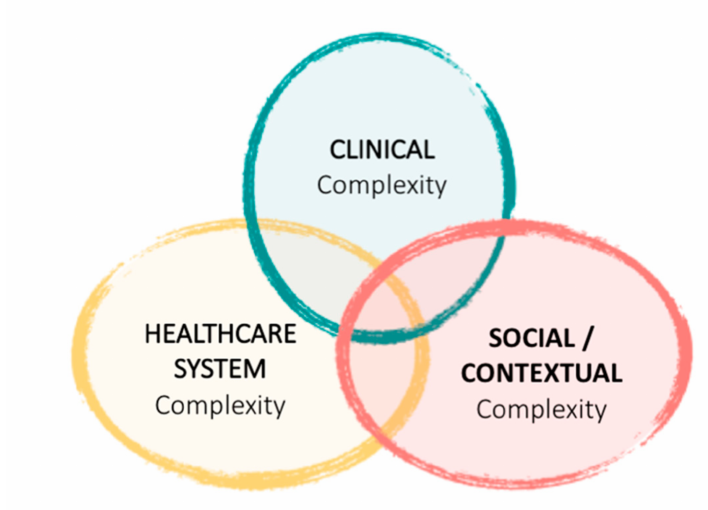
Figure 1. Dimensions of complexity. Adapted from de Kuipers et al.